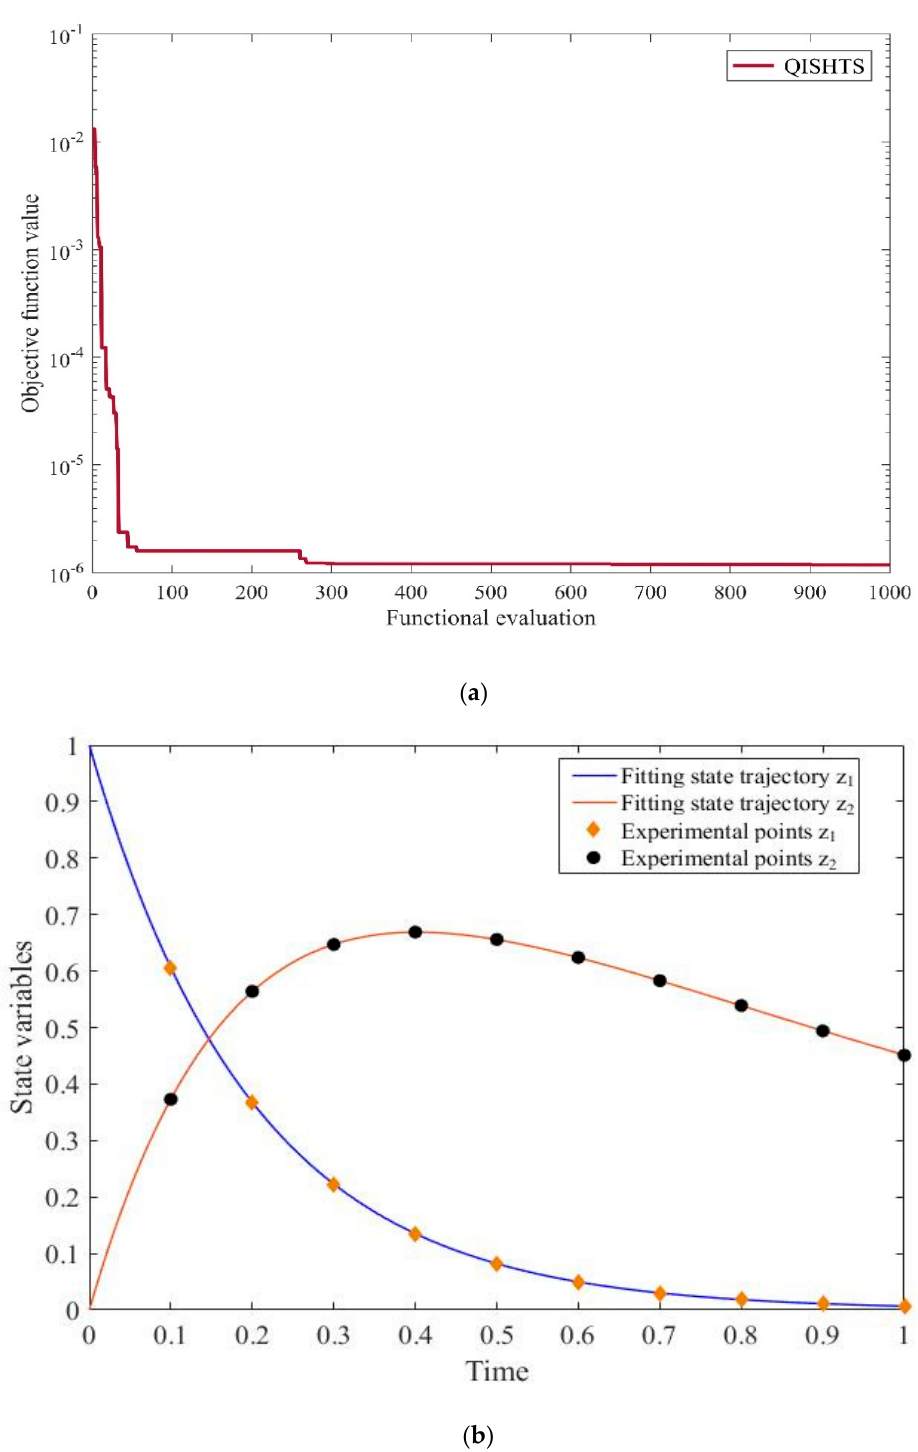
Figure 3. ( a ) Convergence graph of the QISHTS algorithm for the first-order reversible series reaction model. ( b ) Fitting state trajectories and experimental points for the first-order reversible series reaction model.